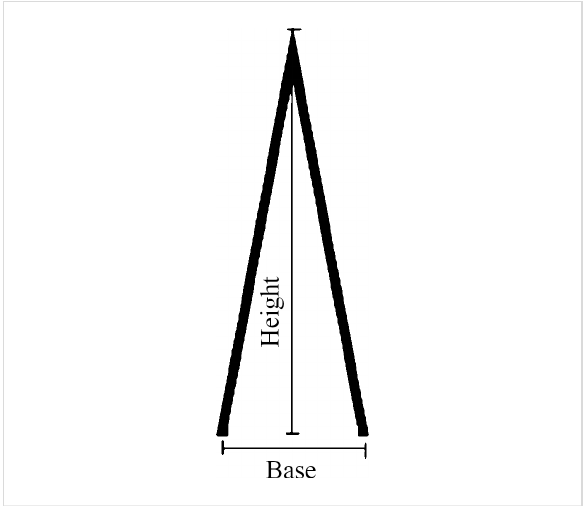
Figure 7: Schematic representation for the analysis of the height and base measurements of the